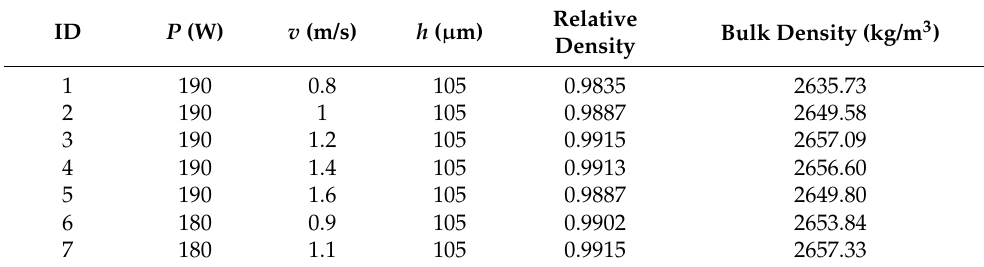
Table A5. Manufacturing parameters and experimental data adapted from [19]. Complementing relevant information and assumptions are the following; material: AlSi10Mg, theoretical